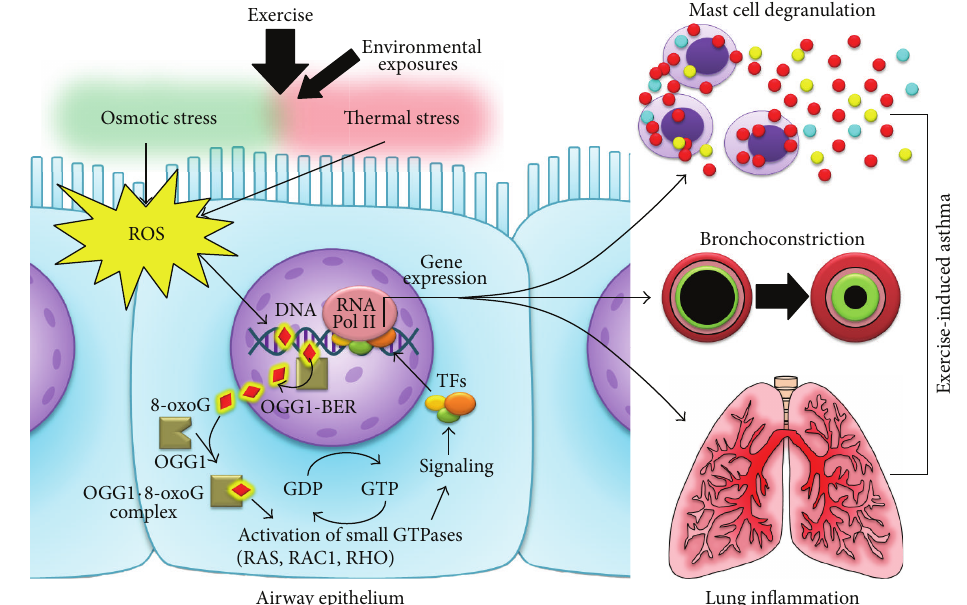
Figure 4: Proposed role for OGG1-BER in asthma and EIA-related gene expression. The large inhaled air volumes during physical activity decrease the temperature and water content of the airway epithelium lining fluid, leading to supraphysiological ROS production by epithelial cells, which can be exacerbated by exposures to environmental pollutants. ROS-induced 8-oxoG lesions in the DNA are repaired by OGG1- BER. In the cytosol, 8-oxoG complexes with OGG1 and acts as a guanine nucleotide exchange factor (GEF), activating small GTPases and initiating a signaling cascade that leads to the translocation of transcription factors (TFs) initiating the transcription of genes associated to AHR, mast cell degranulation, and